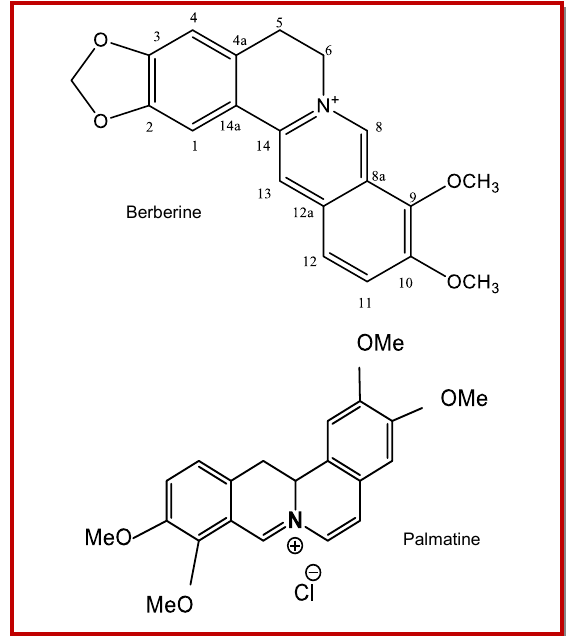
Figure 1: Chemical structure of berberine and